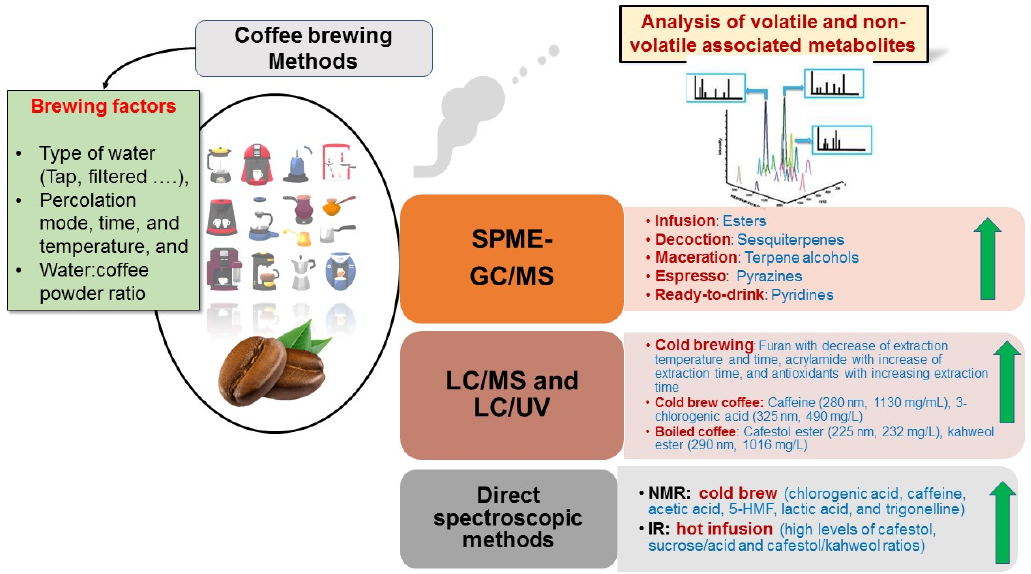
Figure 3. List of the different brewing factors contributing to volatile and non-volatile metabolic profiles of coffee brews. The metabolites markedly increased with specific brewing methods are mentioned based on the detection method used.